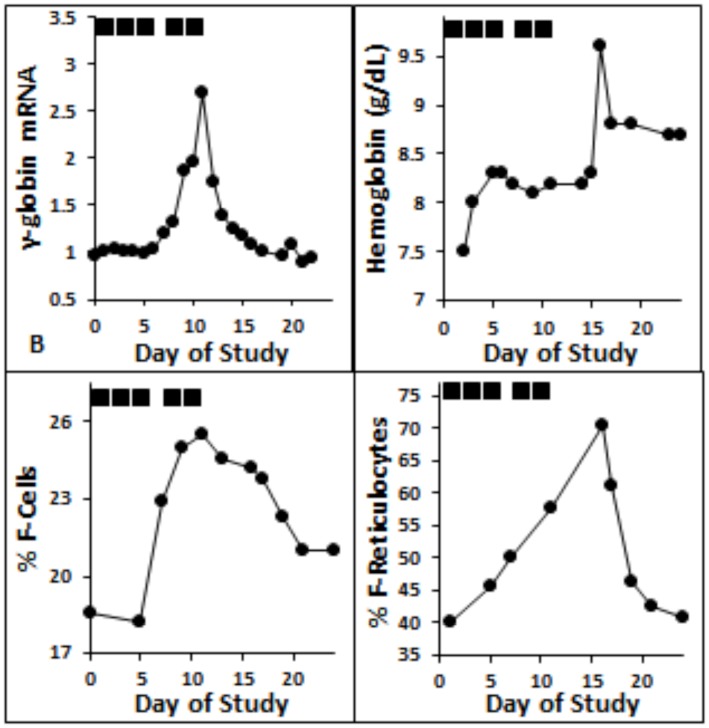
Fetal globin induction in an anemic baboon treated with MS-275 (class I HDAC inhibitor).(A.) Treatment with MS-275 (0.2 mg/kg/dose three times/week), shown by the black bars above the graph, resulted in a 2.7-fold induction of γ-globin mRNA, (B.) 7% increase in F-cells, (C.) 30% increase in F reticulocytes, and (D.) a 1 g/dl rise in total hemoglobin despite daily phlebotomy of 6 ml/kg.